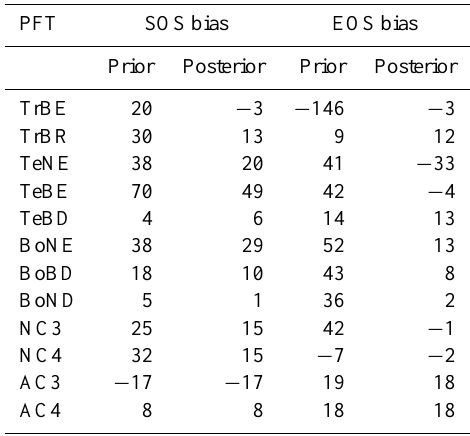
Table 6. Median prior and posterior bias between model- and Table 5. Median prior and posterior correlation between mod- observation-derived start of season (SOS) and end of season (EOS) elled fAPAR and satellite NDVI daily time series and inter-annual anomalies of the annual mean. The metrics are computed for each dates (model – observations). The metrics are computed for each PFT for grid cells that contained > = fraction that was used to select PFT for grid cells that contained > = fraction that was used to select the sites for the PFT in question (see Sect. 2.3.3). the sites for the PFT in question (see Sect. 2.3.3). A negative bias indicates the modelled date is earlier than the one calculated from the observations. PFT Time series correlation IAV correlation Posterior Prior Posterior PFT SOS bias EOS